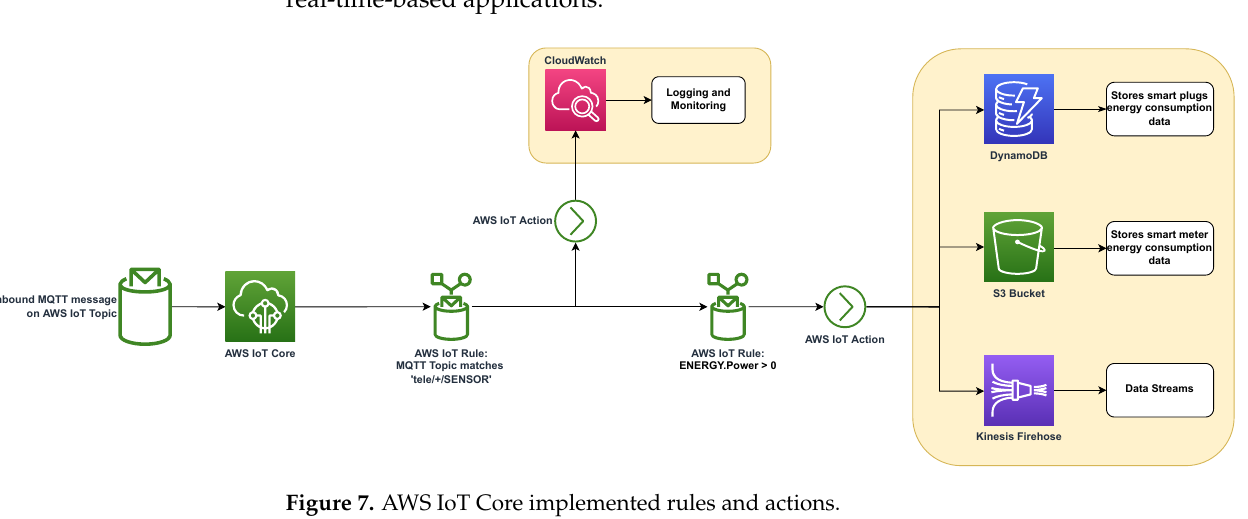
Figure 7. AWS IoT Core implemented rules and actions.